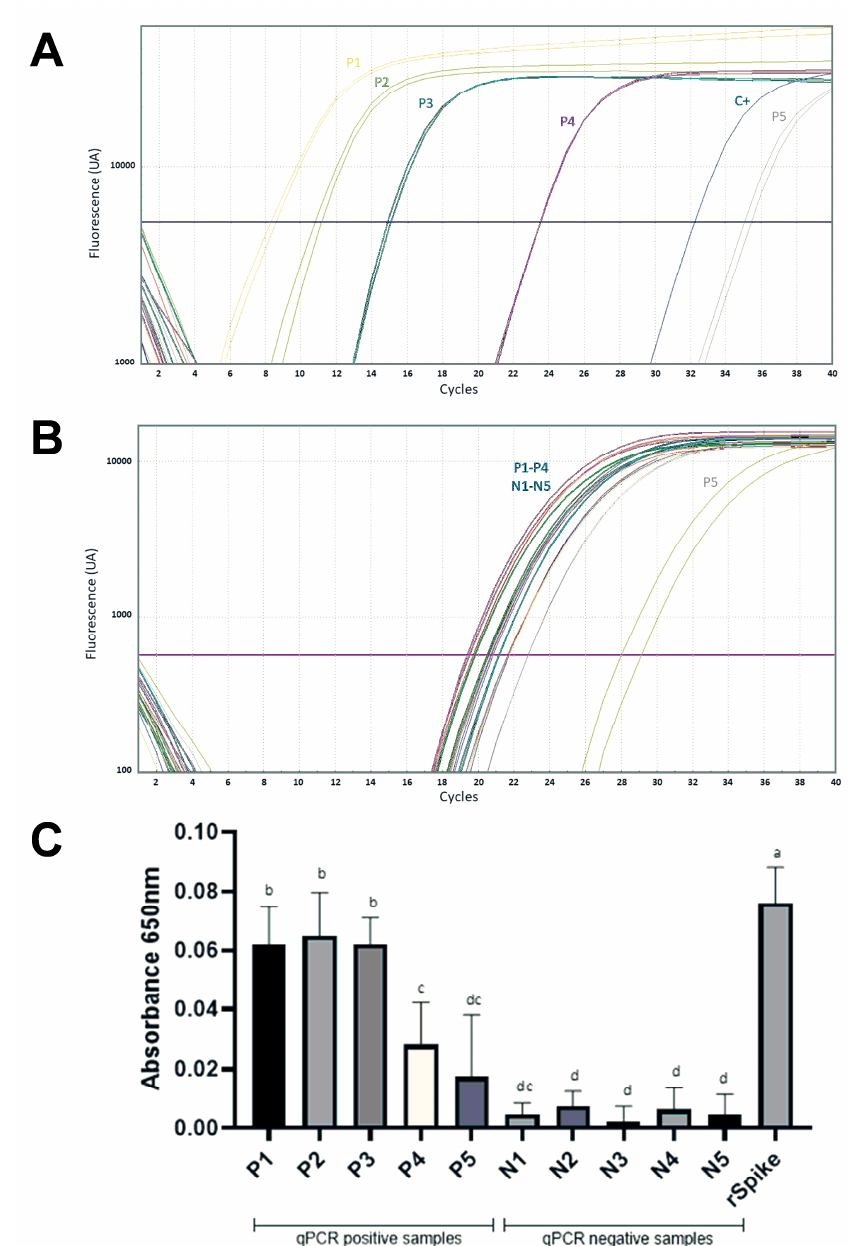
Figure 5. Comparative detection of SARS-CoV-2 on nasopharyngeal swabs by RT-qPCR and bs-ELA. ( A , B ) show the amplification curves of the ORF1ab gene of SARS-CoV-2 and β -actin gene in the nasopharyngeal swabs, respectively. Samples with positive detection of the genetic material of SARS-CoV-2 were named P1 to P5, whereas the negative RT-qPCR samples were named N1 to N5. ( C ) Detection of SARS-CoV-2 on nasopharyngeal swabs by biotin-streptavidin-enzyme-linked assay using ACE2 peptide mimic. Differences were considered significant when p < 0.05 and marked with a different letter after one-way ANOVA.